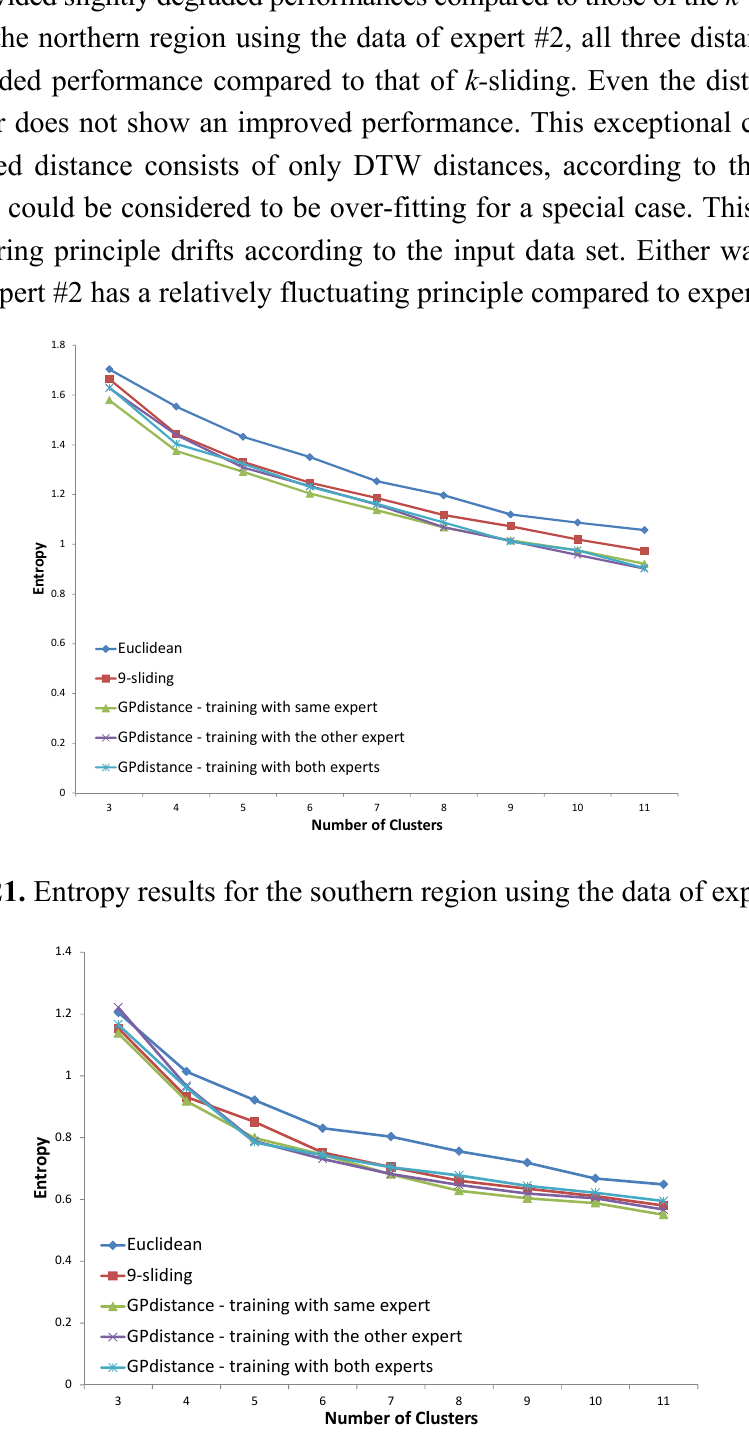
Figure 22. Entropy results for the southern region using the data of expert